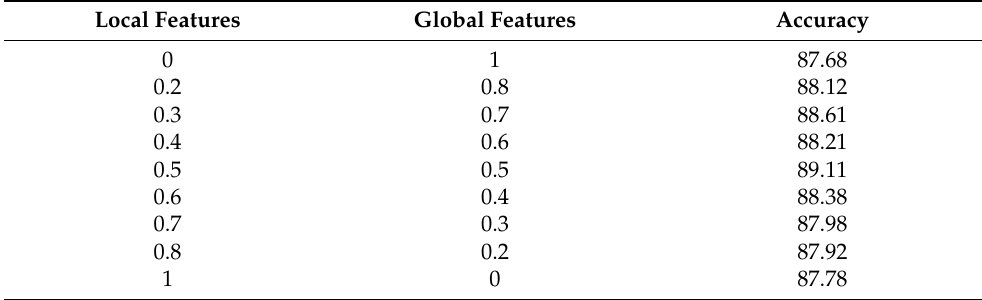
Table 7. The fusion ratio of local and global features. The first column is the fusion factor of local features, the second column is the fusion factor of global features, and the third column is the experimental accuracy after they are fused and passed to the attention